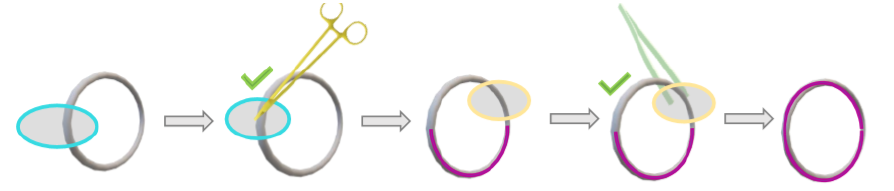
Figure 3. Interactive task schema for simple interrupted suture. The first trigger point (blue color) is activated by the insertion of the needle holder. The thread path is shown in purple. The second trigger point (yellow color) is activated by the insertion of the tweezers.